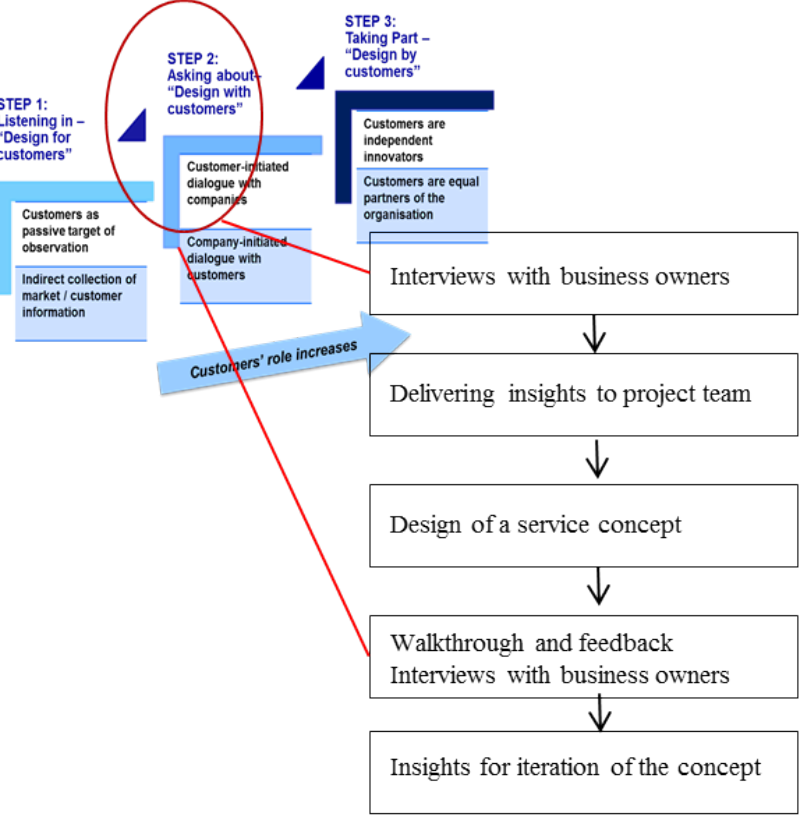
Fig. 2. Steps of co-creation process mapped to NPD